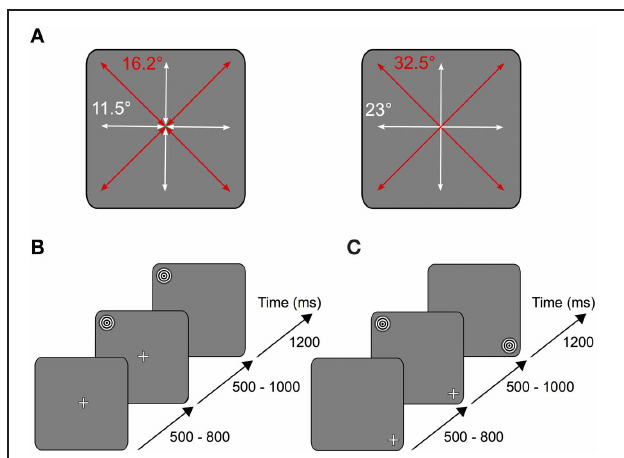
FIGURE 1 | Experimental task. (A) Depending on the stimulus location relative to the fixation cross, subjects performed horizontal and vertical (white arrows) or oblique (red arrows) saccades on the screen. Left: short saccades (11.5 ◦ vertical and horizontal, 16.2 ◦ oblique) were either performed from the periphery to the center or from the center to the periphery. Right: long saccades (23 ◦ vertical and horizontal, 32.5 ◦ oblique) were performed from the periphery to another peripheral point located opposite across the center. (B) Each trial started as soon as the subject began to fixate the fixation cross located in one of nine possible locations on the screen. After a variable time of 500–800 ms the stimulus was shown in one of the other eight remaining locations on the screen. In the saccade condition the fixation cross disappeared after another 500–1000 ms, thus serving as the cue for the subject to make a saccade onto the stimulus. (C) In the fixation condition, instead of the fixation cross disappearing, the stimulus was relocated onto the position where the subject